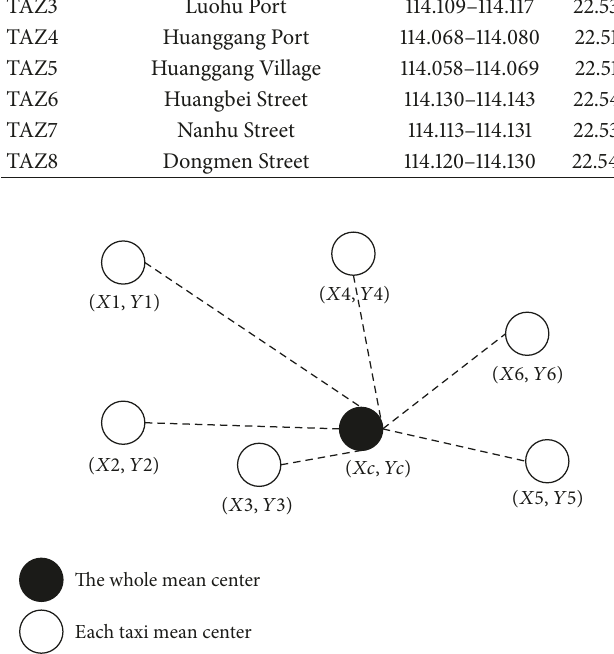
Figure 1: An illustration of the mean center locations of each taxi driver and all taxi